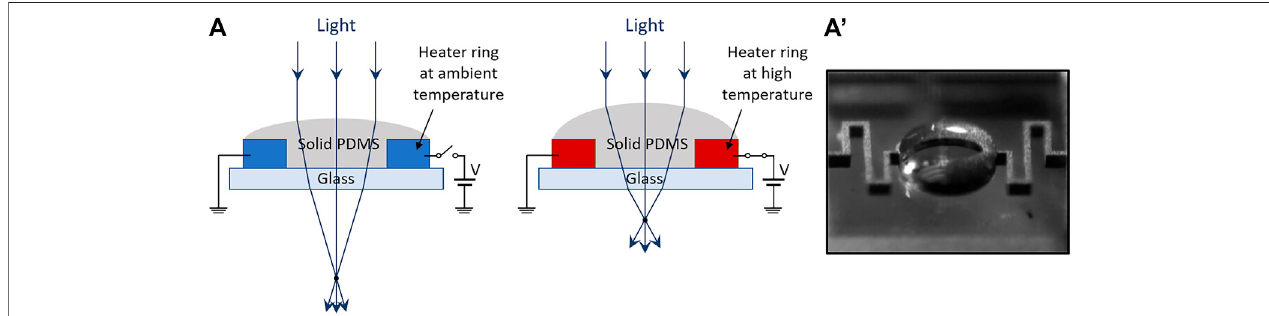
FIGURE 8 | Electro-thermally shaped elastomeric lens: (A) Structure (example among various alternatives) and related principle of operation: an electro-thermal expansion of the polymeric lens increases its curvature; (A 9 ) prototype sample, reproduced with permission from (Lee et al., 2007).